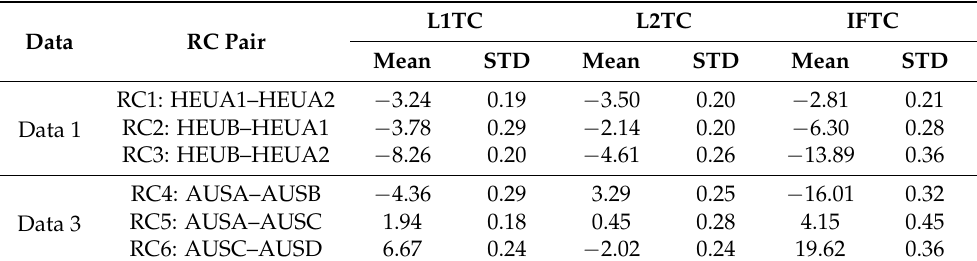
Table 3. Statistics of the ISB from different tightly coupled methods (m).